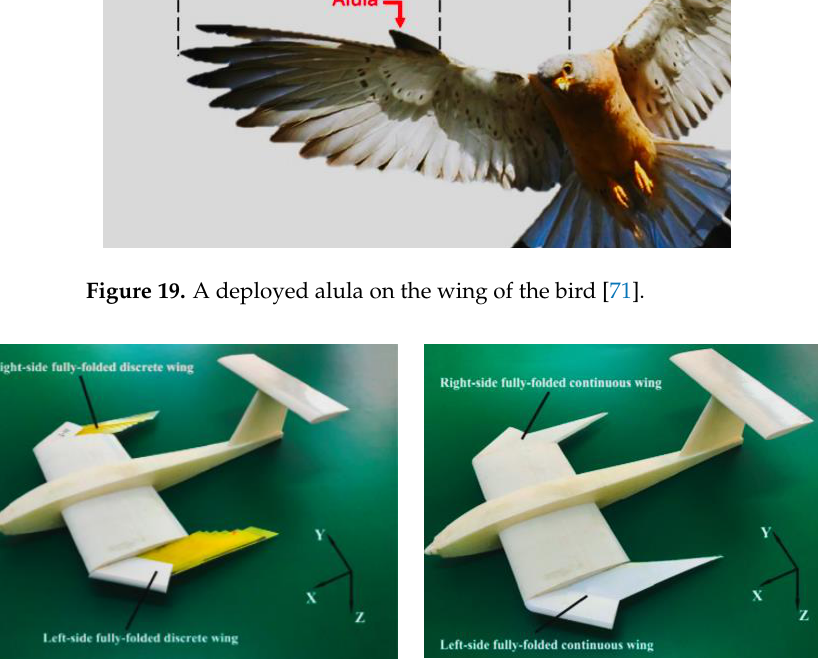
Figure 19. A deployed alula on the wing of the bird[71].